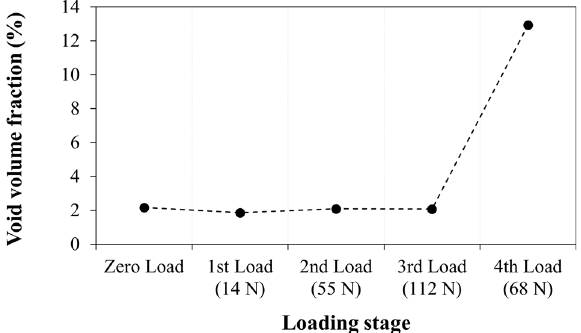
Fig. 5 Evolution of void (i.e. sum of cracks and pores) volume fraction with externally-applied load The same process was followed to calculate the corresponding mean vertical displacement values for the cuboid shown in Fig. 7d. The absolute difference between the top and bottom mean displacements on each occasion designated the vertical deforma- tion occurred at a speci fi c load-transition phase. The load difference, vertical deformation and geometry of the investigated sample on each occasion were used to determine the relative compressive stress and vertical strain, enabling subsequent calculation of the Young ’ s modulus. Similar concepts have been adopted to reveal the mechanical properties of quasi-brittle, heterogeneous materials based on DVC-measured data 29 . Sepa- rate values for the Young ’ s modulus value were determined for each DVC run. Since two different load transition scenarios were investigated (14 N – 55 N; 14 N – 112 N), a mean Young ’ s modulus value was calculated. The strain method was employed to corroborate the results produced via the displacement method. The axial strain values